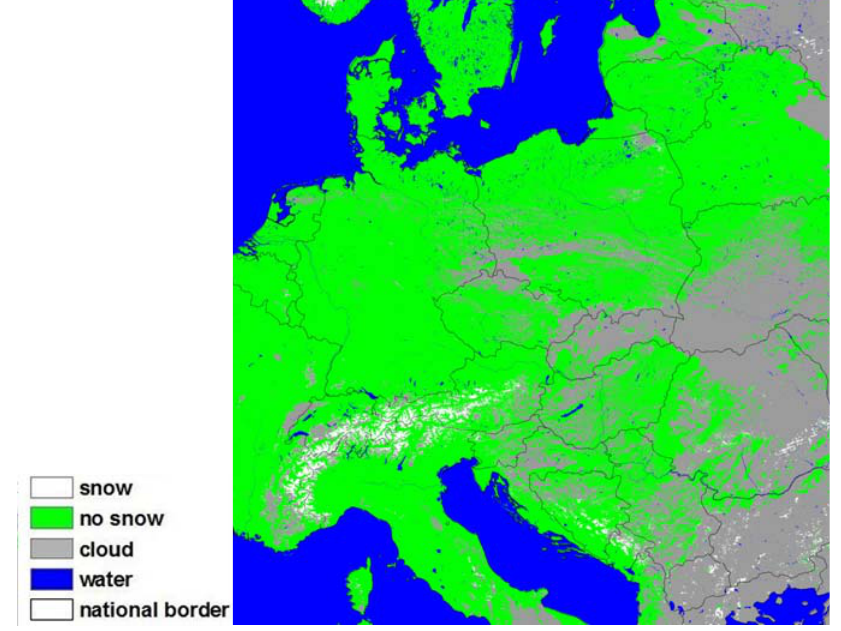
Figure 6. Example of SCA maps from MODIS (Terra and Aqua combined) data acquired over Europe on 18 April 2011 obtained with the EURAC algorithm.